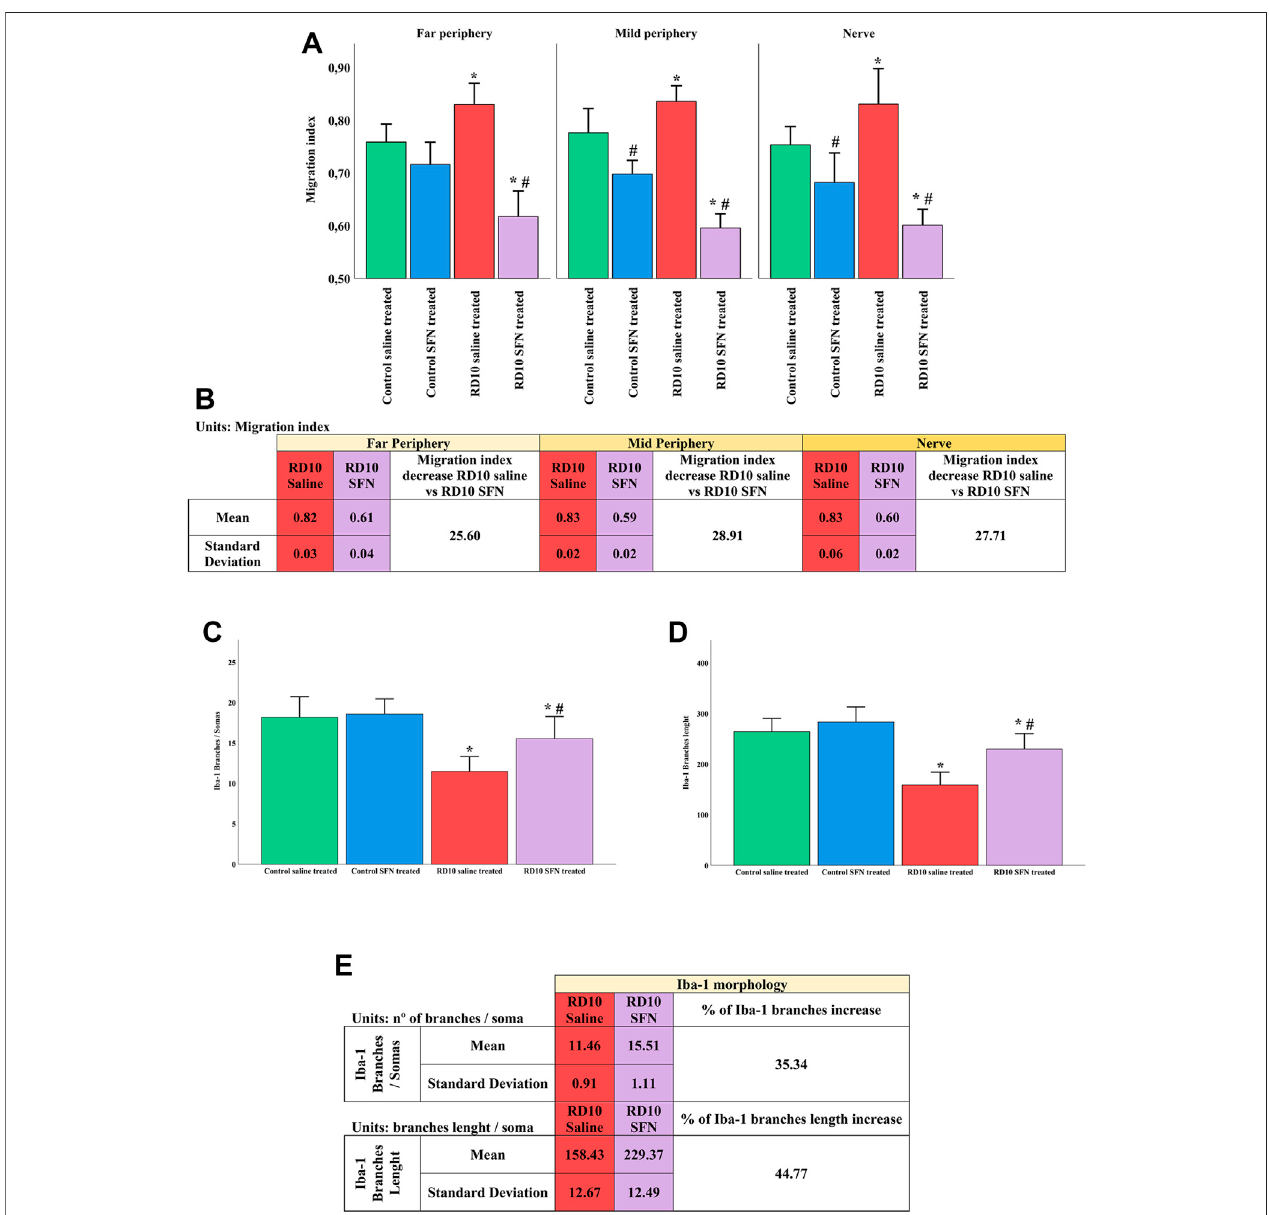
FIGURE 6 | Microglia activation analysis. (A) Migration index. (B) Migration index: Mean and standard deviation of RD10 Saline and migration index RD10 SFN groups, and percentage decrease in RD10 SFN with respect to the RD10 Saline. (C) Branches of Iba1 cells per soma. (D) Branch length of Iba1 cells. *Differences between Control Saline vs. RD10 Saline or Control SFN vs. RD10 SFN ( p -value < 0.05). #Differences between RD10 Saline vs. RD10 SFN ( p -value < 0.05). (E) Iba1 morphology: Mean and SD of RD10 Saline and RD10 SFN groups, and percentage increase in RD10 SFN vs. RD10 Saline.